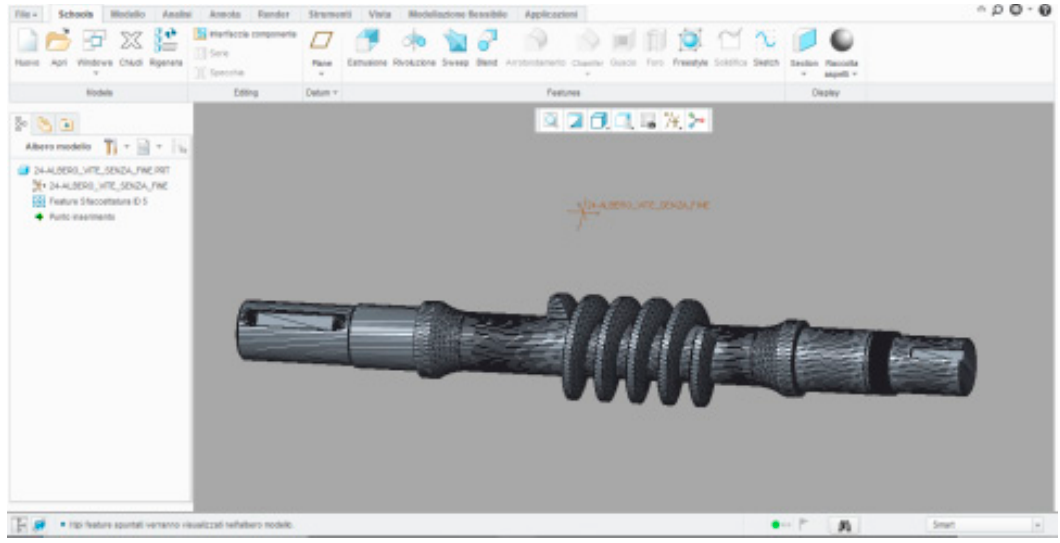
Figure 24. View of the tree in obj with PTC Creo Parametric 3.0.